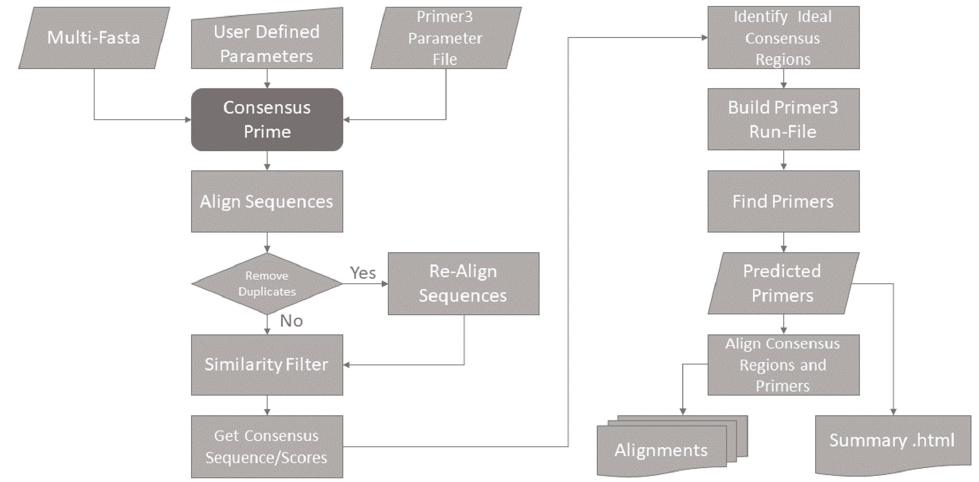
Figure 2. ConsensusPrime workflow. Overview of the ConsensusPrime pipeline with all input/output files and user-provided parameters.